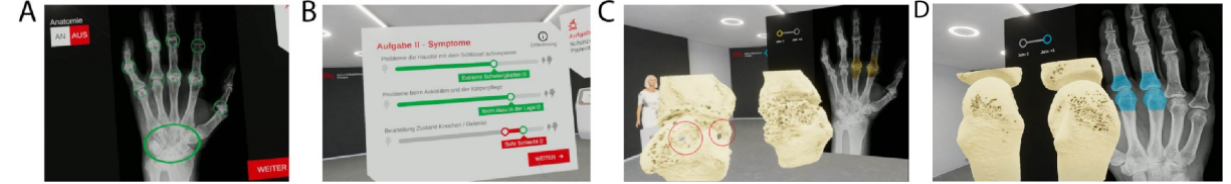
Figure 1. Learning tasks in the VR application for teaching of IA. Depiction of 2D hand X-ray of a patient with arthritis on which the user has interactively identified joint pathologies (green circles) (A). In another task, the user is asked to assess the disease burden of the same patient after evaluating the X-ray images (B), 3D CT image of the same pathologies of the X-ray image, the user can rotate and immerse with these images and is asked to define specific pathologies such as erosions (red circle) (C). (A, C) show images of a patient with long-standing (inadequately treated) RA, (D) CT images of a patient with early RA.